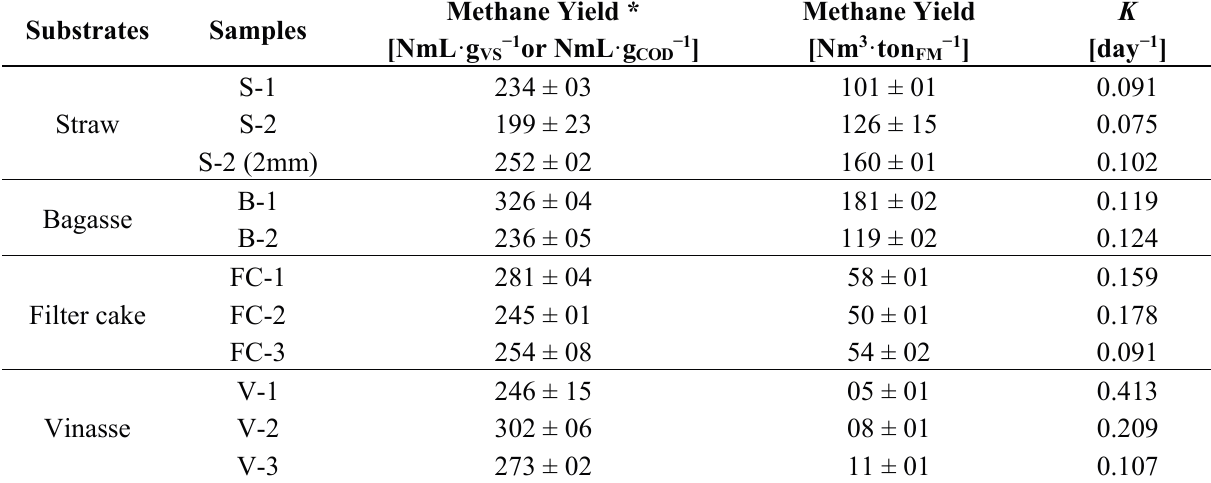
Table 4. Biochemical methane potential of the sugarcane waste after 35 days of assay.